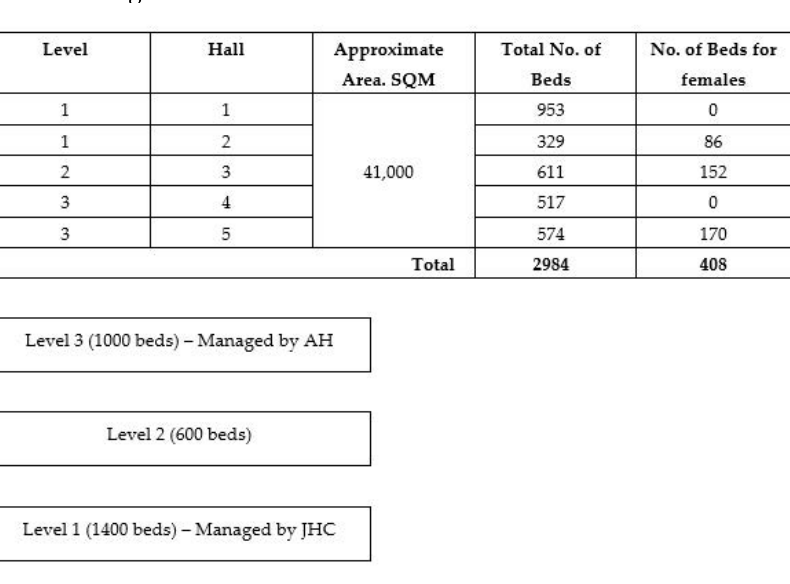
Figure 1. Infrastructure of the community care facility (CCF)@Big Box.